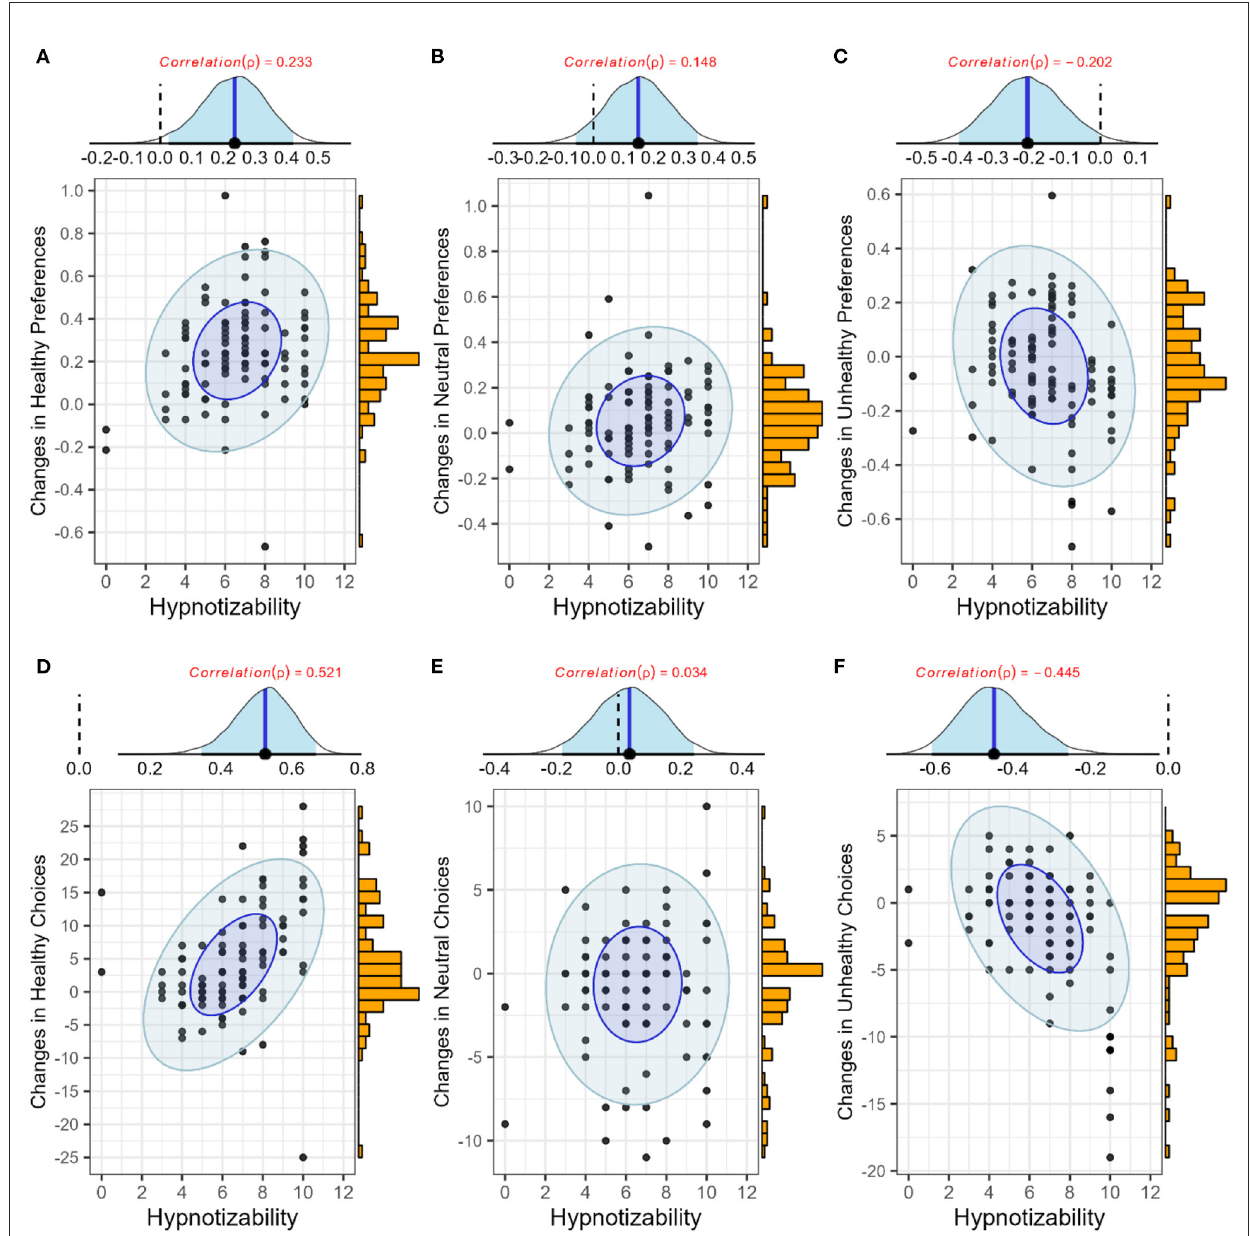
FIGURE8 Effects of hypnotizability on Food Preferences (top) and Food Choice (bottom). Each panel shows three elements. (Top) The posterior distribution of ρ (blue lines and shadows show means and 95% highest density intervals); (right) a histogram of changes in the targeted variable drawn from observations; and (mid) point and eclipse plots, representing the observations and robust posterior predictions, respectively. Dark blue and light blue ellipses show the 50 and 95% highest density areas. (A–C) Changes in preferences for healthy, neutral, and unhealthy items; (D–F) Changes in choices of healthy, neutral, and unhealthy